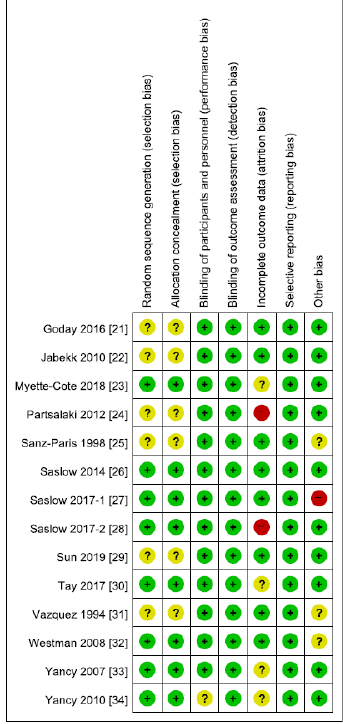
Figure 2. Risk of bias summary.